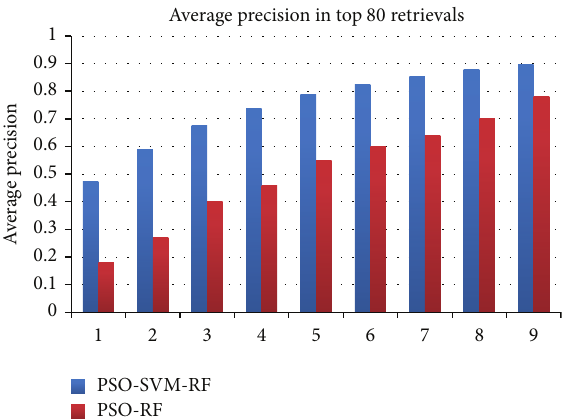
Figure 5: Performance of the proposed PSO-SVM-RF compared against PSORF